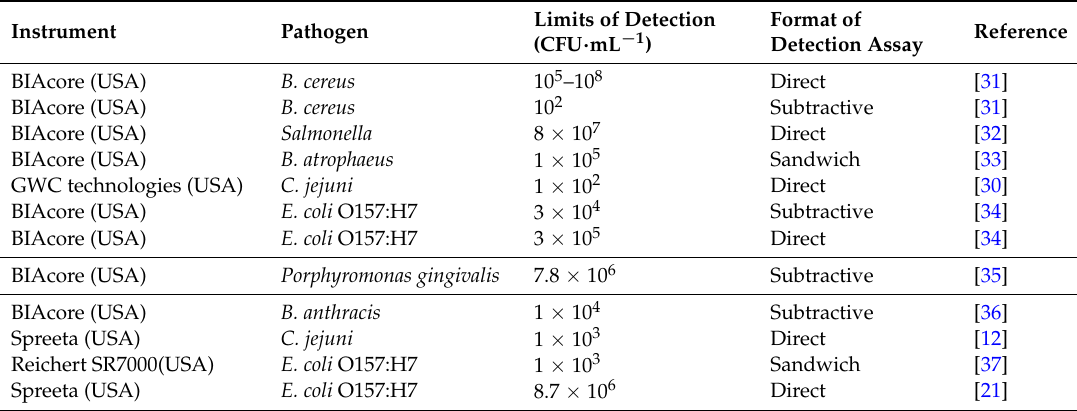
Table 2. Comparison of LOD values on SPR for various bacterial